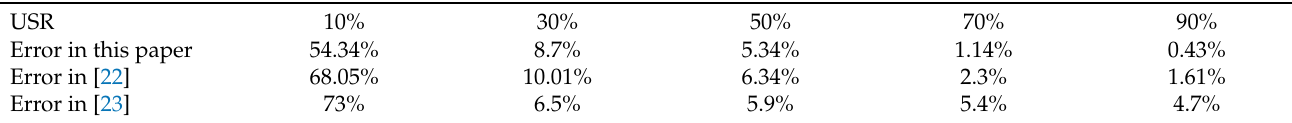
Figure 6. Phase factor and azimuth FFT result of a single line in the range-focusing data slice: ( a ) phase factor, ( b ) azimuth FFT result. Table 2. Error of recovered data with different under-sampled rate (USR).